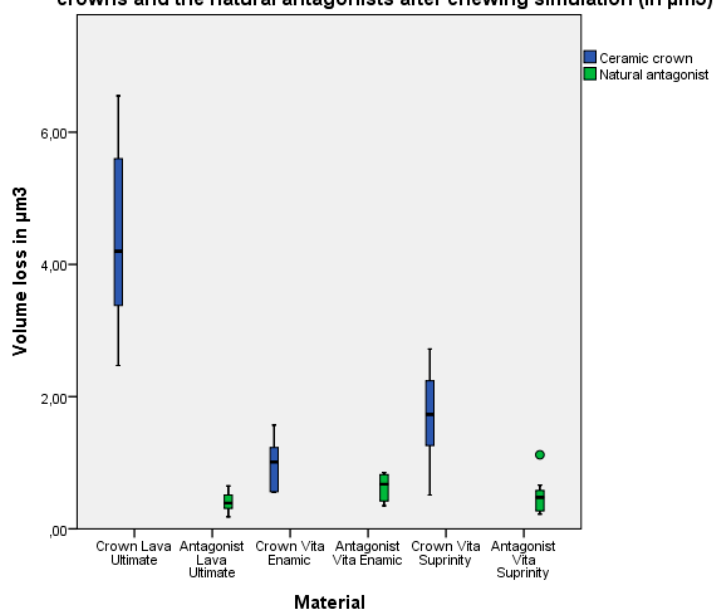
Figure 3. Total occlusial abrasive wear (volume loss) of the full ceramic CAD/CAM molar crowns